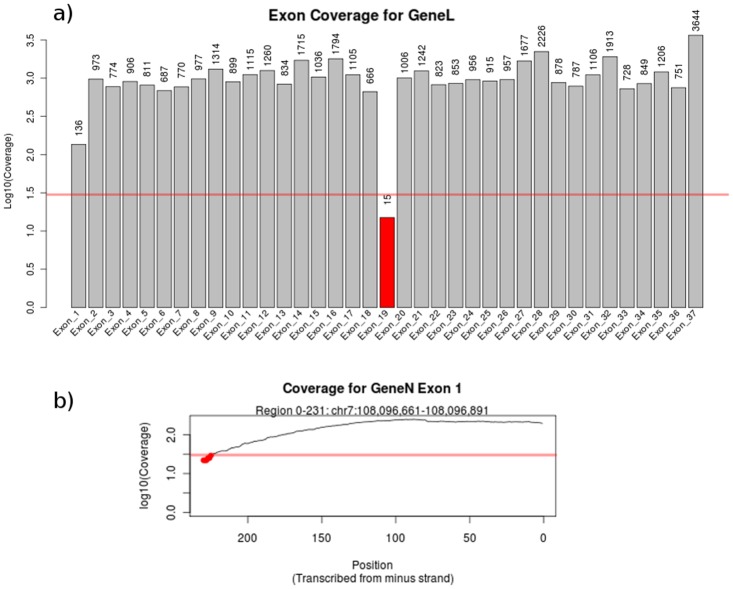
Sections from a coverage report.A) Representation of exon coverage, grouped by gene based on information in the provided BED file. The horizontal red line indicates a user-provided coverage threshold. B) Coverage at base level for one exon, allowing the identification of local drops in sequencing depth.